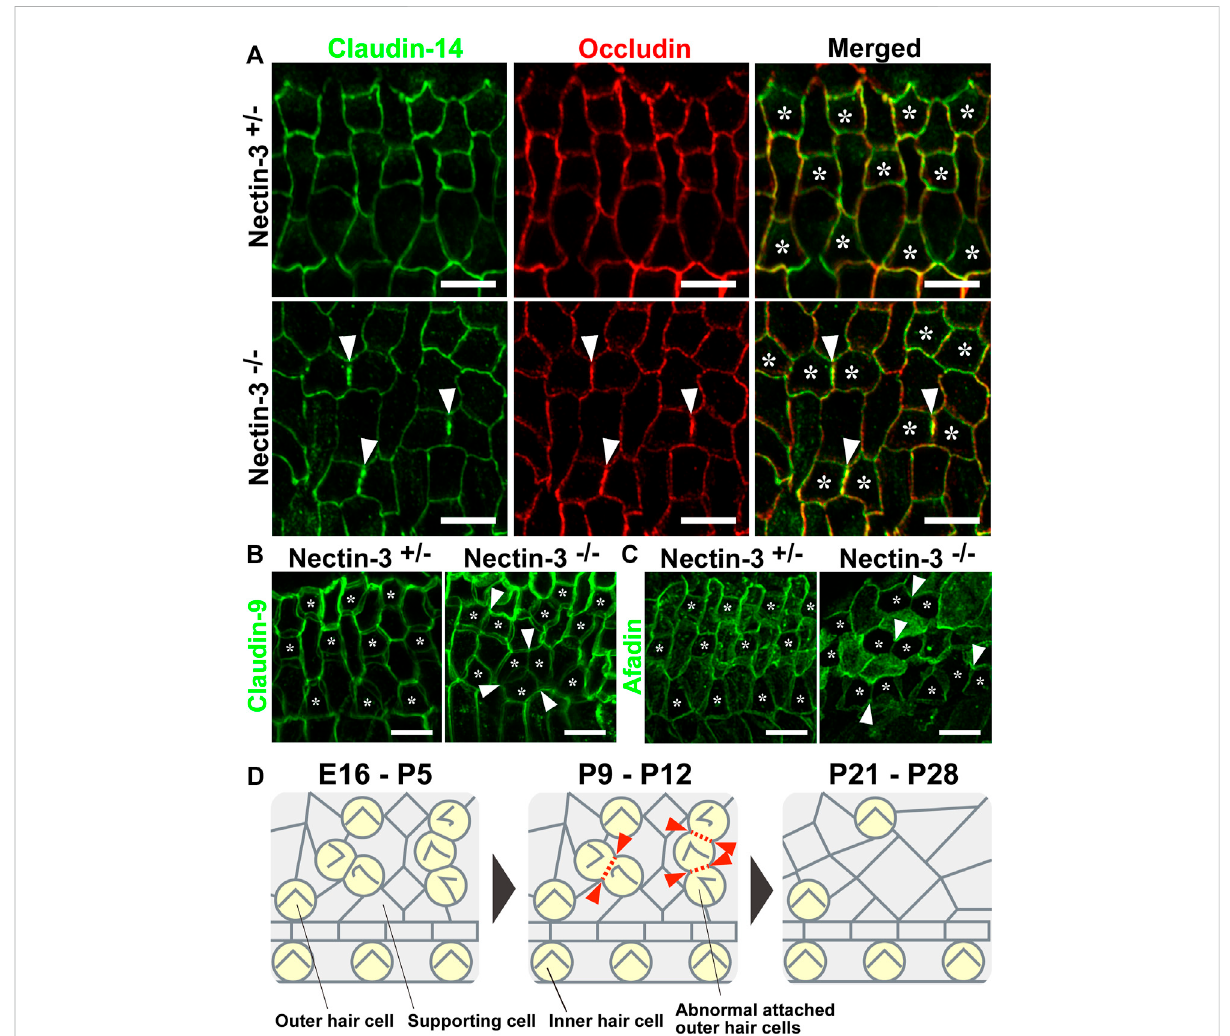
FIGURE 7 Localization of claudin-14, occludin, claudin-9, and afadin in the auditory epithelium in nectin-3 KO mice (A) Immuno fl uorescence images of theorganofCortiinthemiddleturninnectin-3 +/ – andnectin-3 − / − miceonP21usingananti-claudin-14 antibody(green)andanti-occludin (red). (B) Immuno fl uorescenceimagesoftheorganofCortiinthemiddleturninnectin-3 +/ – andnectin-3 − / − miceonP21usingananti-claudin-9antibody. (C) Immuno fl uorescence images of the organ of Corti in the middle turn in nectin-3 +/ – and nectin-3 − / − mice on P21 using an anti-afadin antibody. Whitearrowheadsindicatethehomotypicinterfacesbetweenattachedouterhaircells,andasterisksindicatetheouterhaircells.Scalebarsare5 μ m. (D) Schematic illustrations of the cellular patterns and TJ loss in the auditory epithelium of nectin-3 KO mice. Red arrowheads indicate the positions of homotypic junctions between outer hair cells. Red dotted lines indicate the loss of TJ components from the homotypic junctions between hair cells. See also the Discussion for